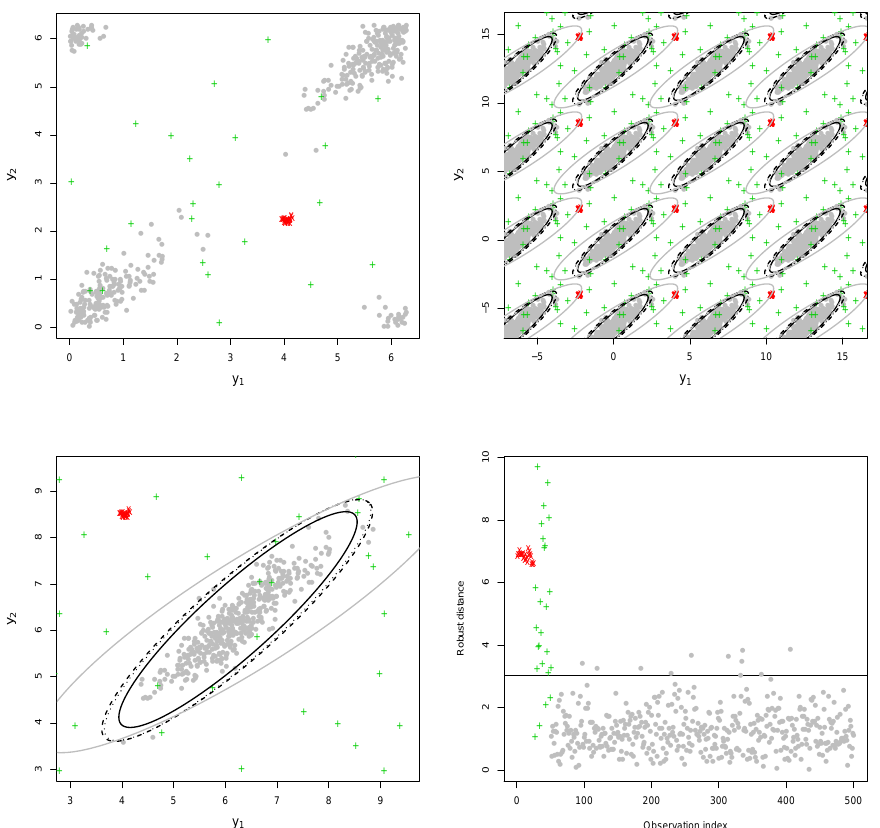
Figure 3. Second synthetic example. Top-left : Original circular data. Top-right : Data, fitted models (WLE-solid line, trimming-dashed line, MM-dotted line, and MLE-solid gray line) and true model (dashed gray line) on a flat torus. Bottom-right : Fitted tolerance ellipses. Bottom-left : Distance plot. Genuine data are in gray, scattered outliers in red, and clustered outliers in green.